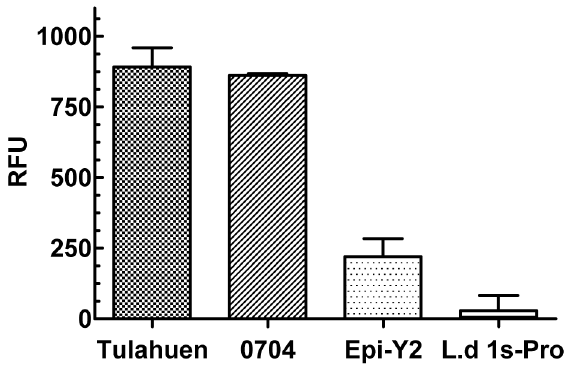
Figure 4. Aptamer L44 binds to a conserved target present in TESA from two strains of T.cruzi . Cell free culture supernatants, containing the excreted secreted antigens, from T. cruzi Tulahuen and 0704 strains were coated using 50 m l/well of 10 ng/ m l dilution, and an ELA assay performed using biotinylated Apt-L44. As controls for specificity, culture supernatants, at 10 ng/ m l, from axenic T. cruzi Y2 strain epimastigotes (Epi-Y2) and L. donovani 1 s promastigotes (L.d 1 s- Pro) were also used. Signal generated, relative fluorescence units (RFU), are plotted on the Y-axis and each point represents the mean of duplicate values with standard